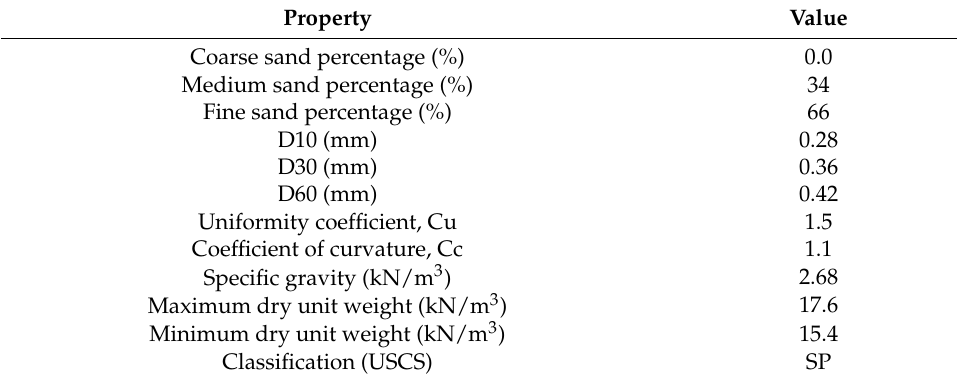
Figure 4. Grain size distribution of the sand. Table 1. Properties of sand